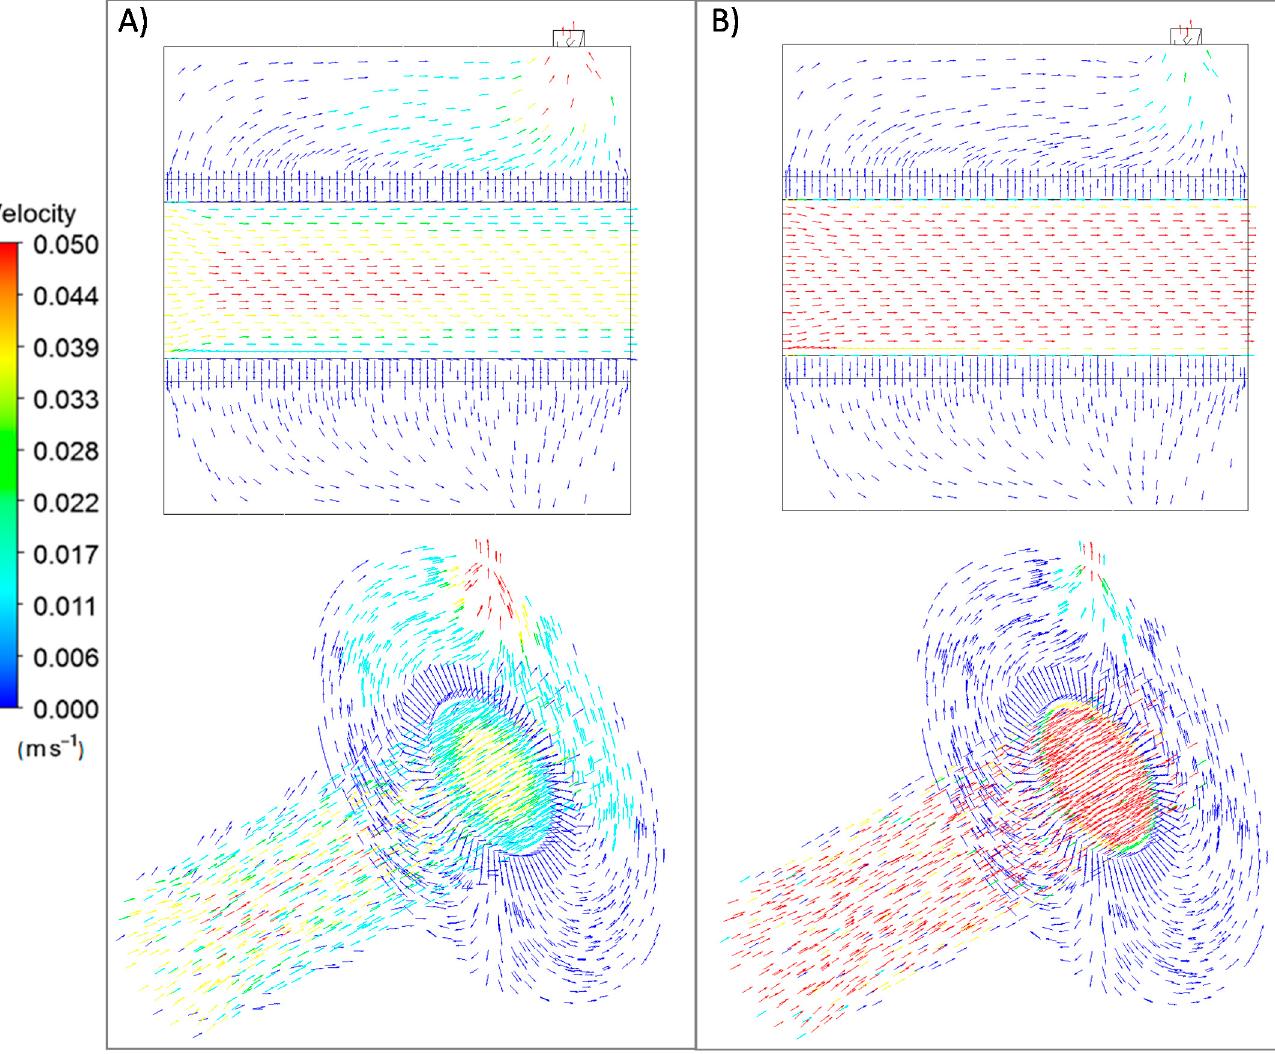
Figure 5. Modeled velocity vectors during permeation at T = 375 °C, Δ P = 2 bar, in–out configuration, and different H 2 molar fractions in the feed stream: ( a ) 0.9 and ( b ) 0.5.